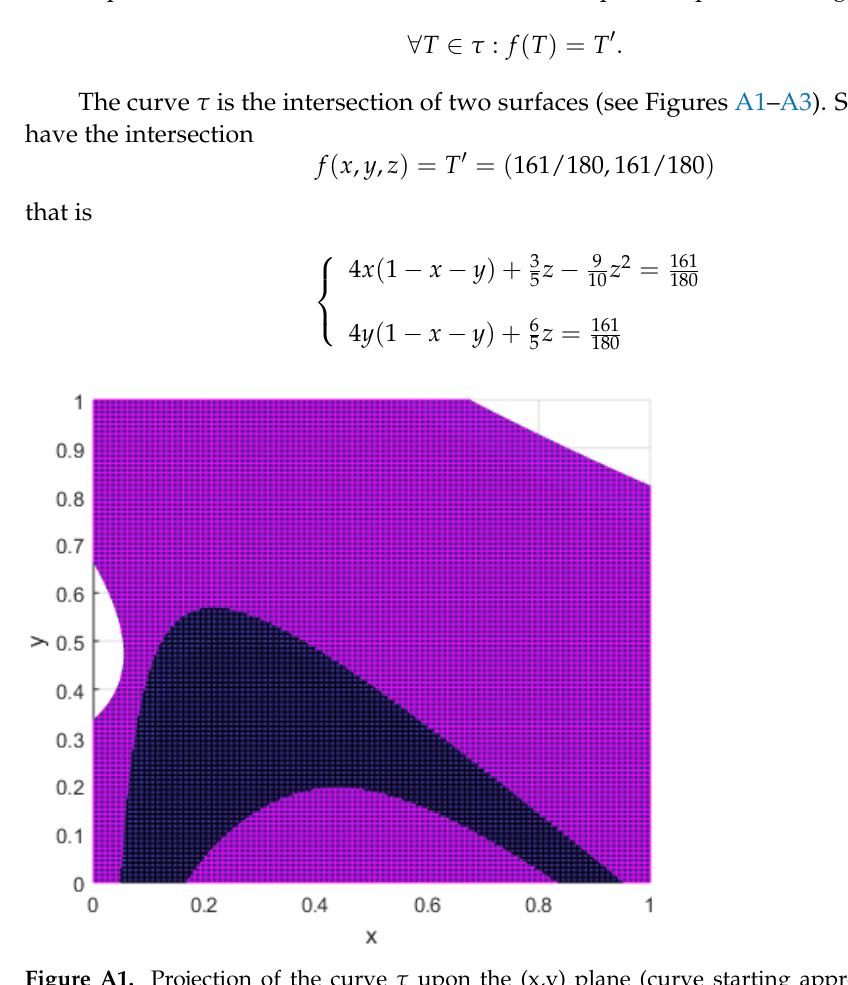
Figure A1. Projection of the curve τ upon the (x,y) plane (curve starting approximately from 0.2 to 0.8).